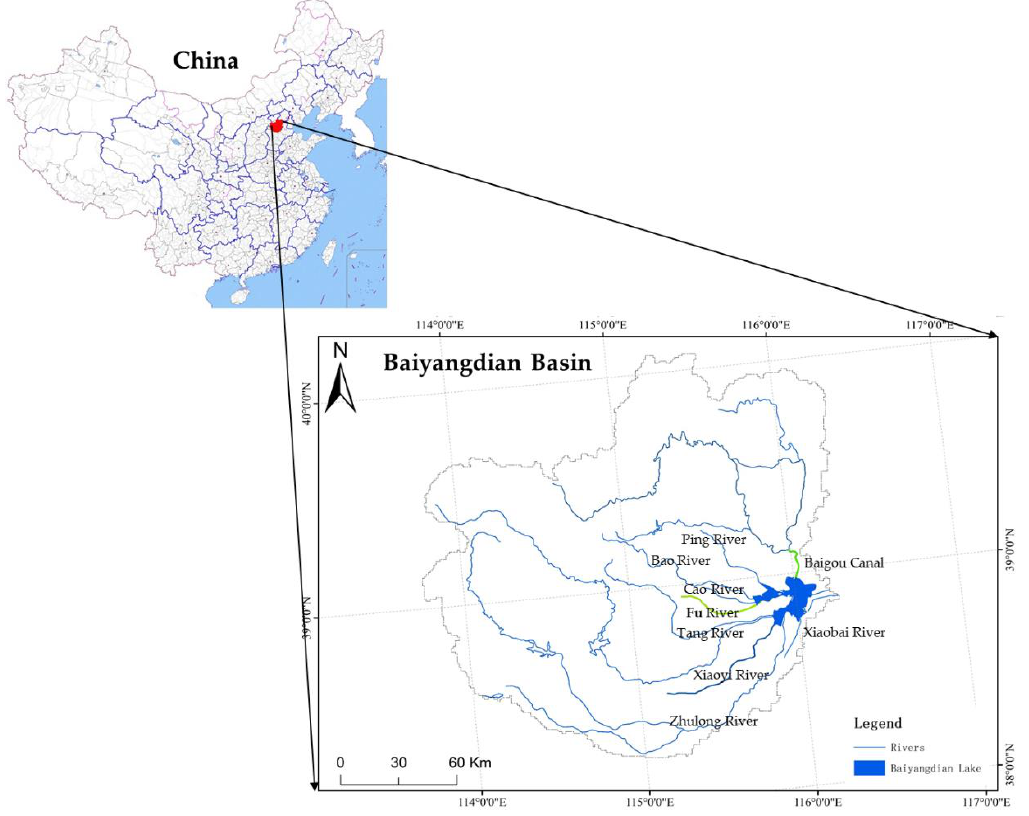
Figure 6. Location of the study area, of Baiyangdian Lake, and of the main rivers that enter the lake.